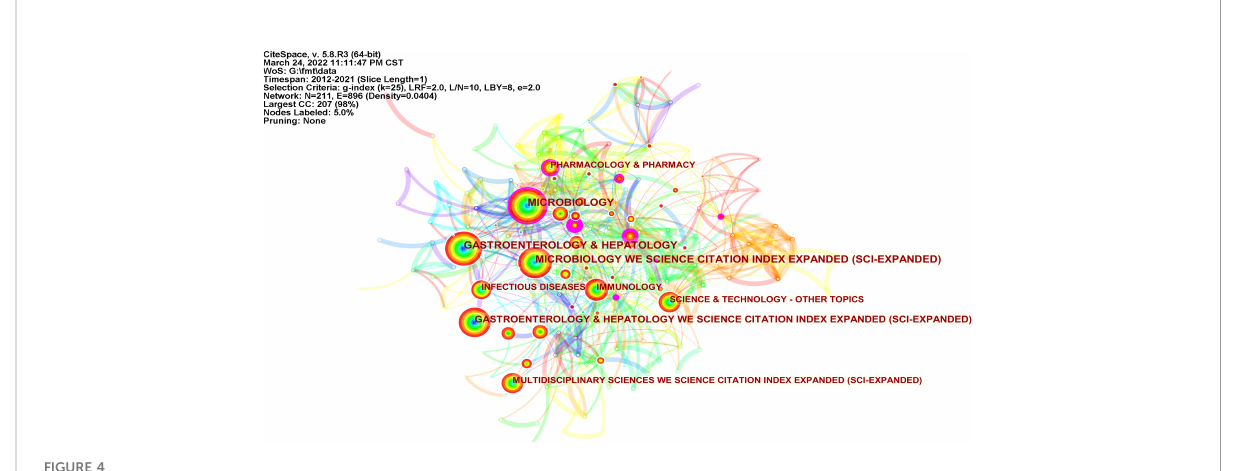
FIGURE 4 Map of categories related to FMT (N=211,